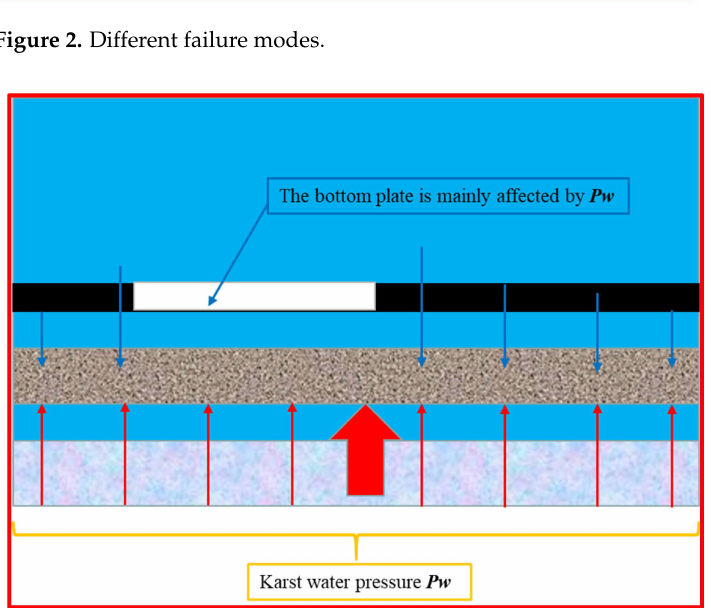
Figure 3. Mechanical model of the bottom slab subjected to karst water